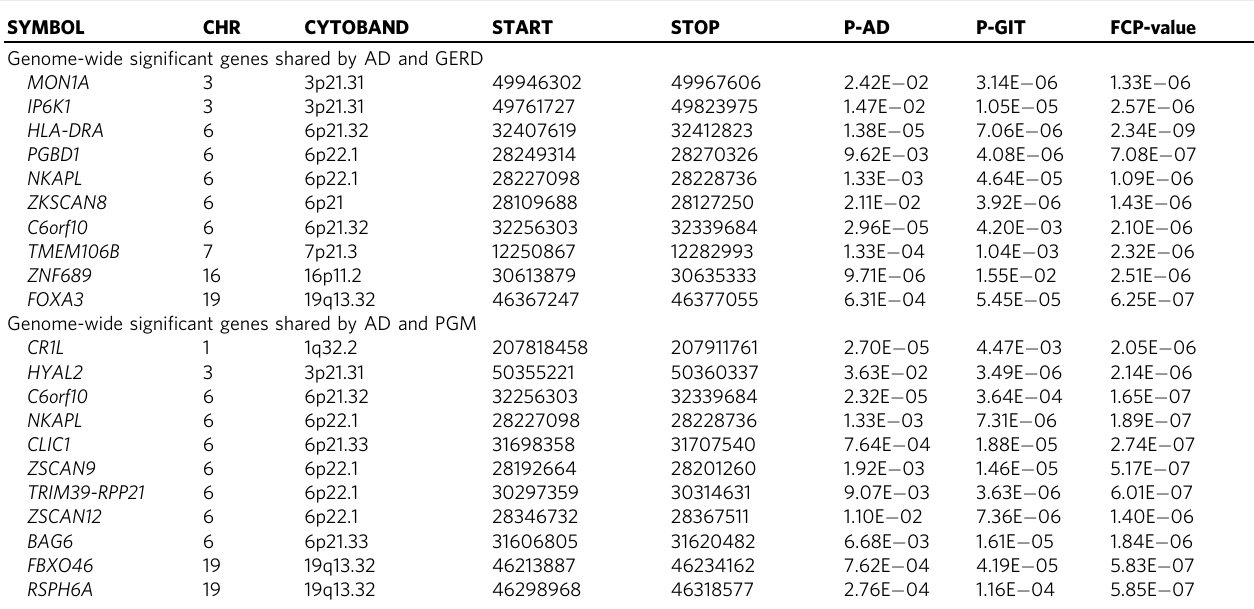
Note: genes reported in this Table were not previously genome-wide in the gene-based analysis for the individual AD and GIT GWAS analysed but reached the status following FCP analysis. CHR chromosome, P-ADP valueforAlzheimer ’ sdisease, P-GITP valueforgastrointestinaltracttrait, FCP Fisher ’ scombined P value, GERD gastroesophagealre fl uxdisease, PGMGWAScombiningdisease- diagnosis of PUD and/or GERD and/or medications for their treatments